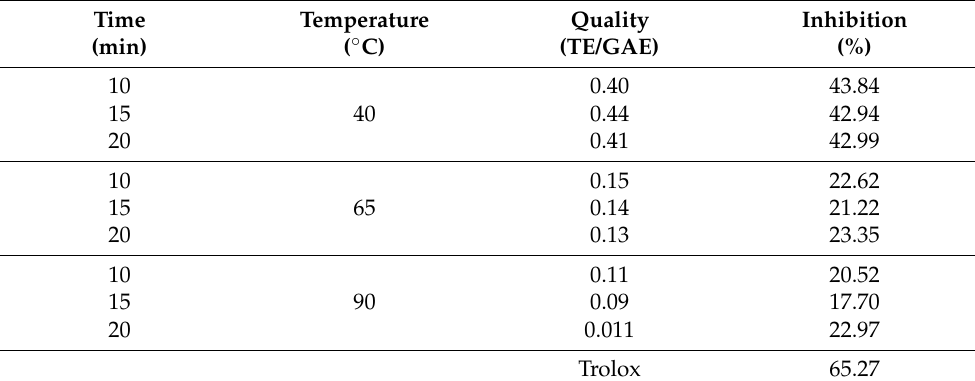
Table 6. The quality (represented as Trolox equivalent/GAE) and % of inhibition capacity of apple pomace extracted samples against the radical DPPH (after 15 min) and commercial antioxidant Trolox at 0.05 g/L of concentration .